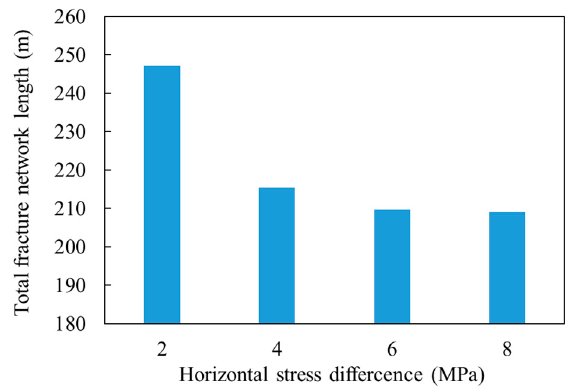
Figure 9. Fracture network lengths at different horizontal stress differences.